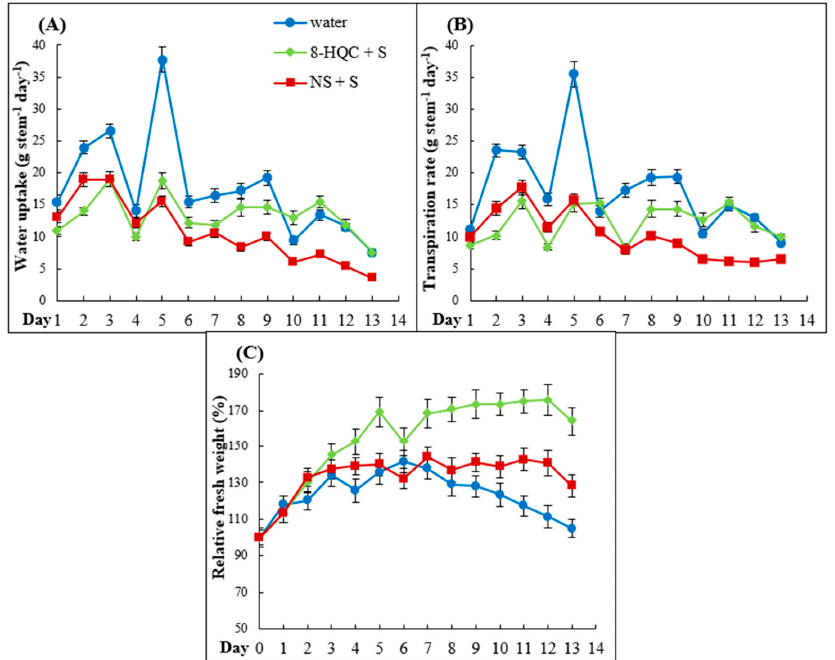
Figure 2. The effect of preservatives on water balance in cut peony ‘Charles Binder’ flowers. Water uptake ( A ), transpiration rate ( B ), and relative fresh weight ( C ) of cut peony flowers. Values are expressed as the mean ± SD. Vertical bars represent standard deviations of the means. Table 3. The effect of preservatives on the water balance parameters in cut peony ‘Charles Binder’ flowers.